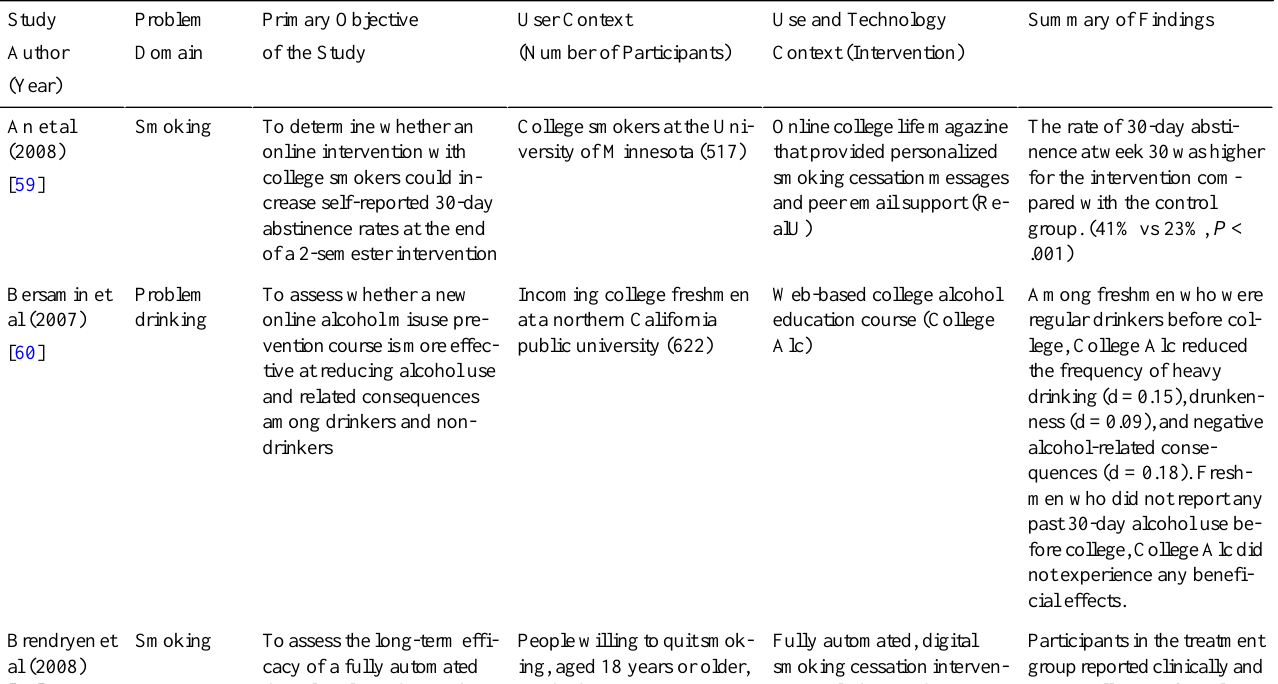
Summary of FindingsUse and